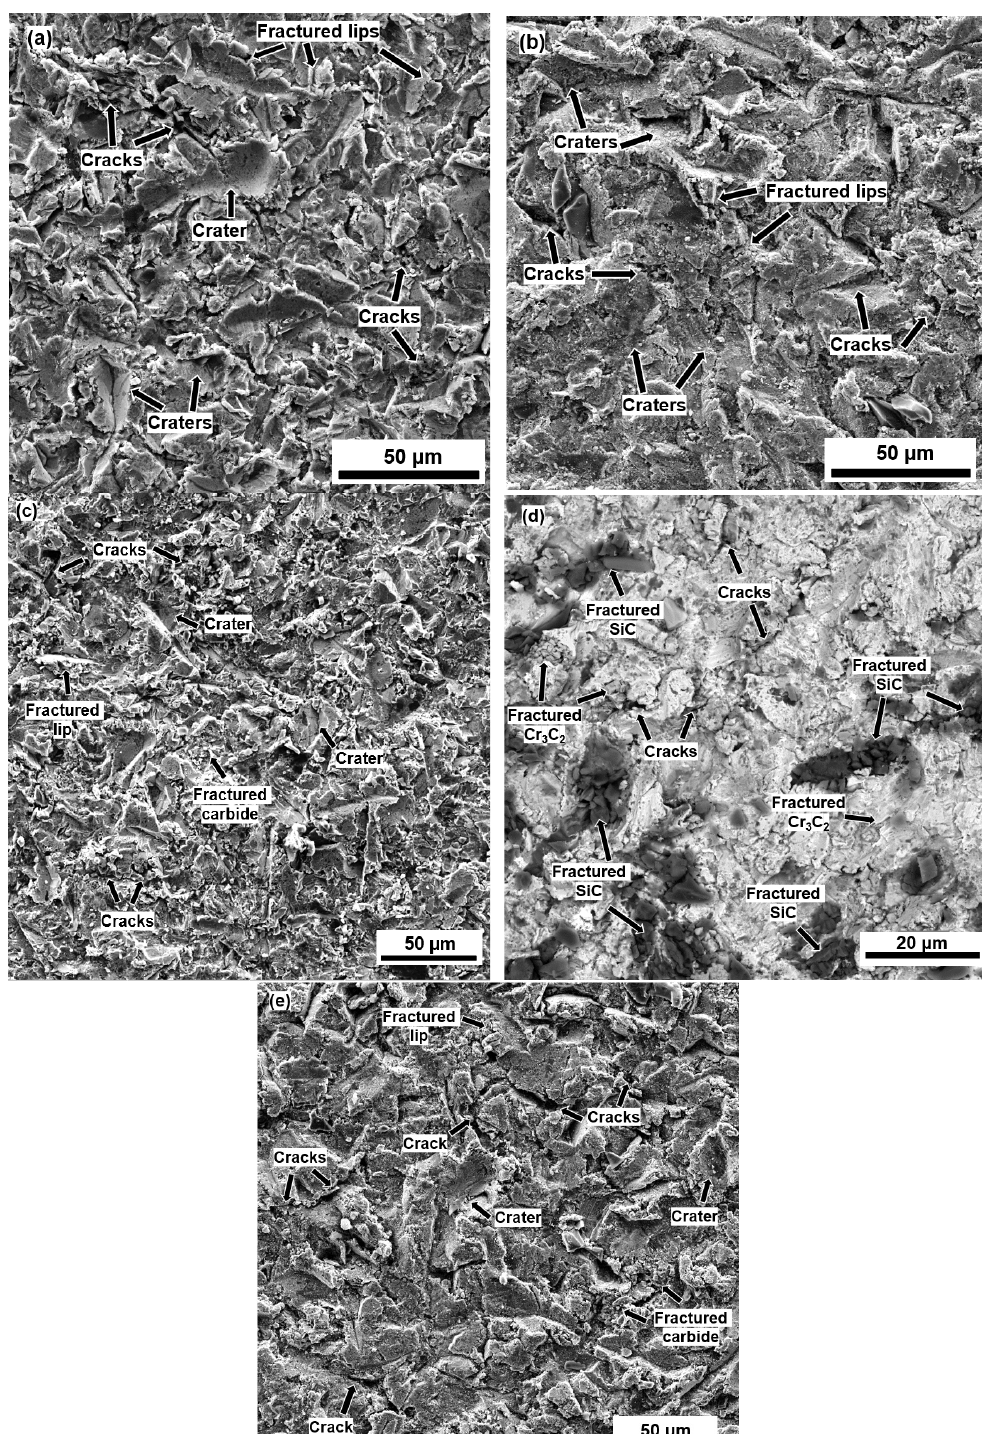
Figure 12. Eroded surface 90° angle: ( a ) C1 at RT and ( b ) at 900 °C. ( c ) C2 at RT; ( d ) RT, backscattered electrons; and ( e ) at 900 °C.